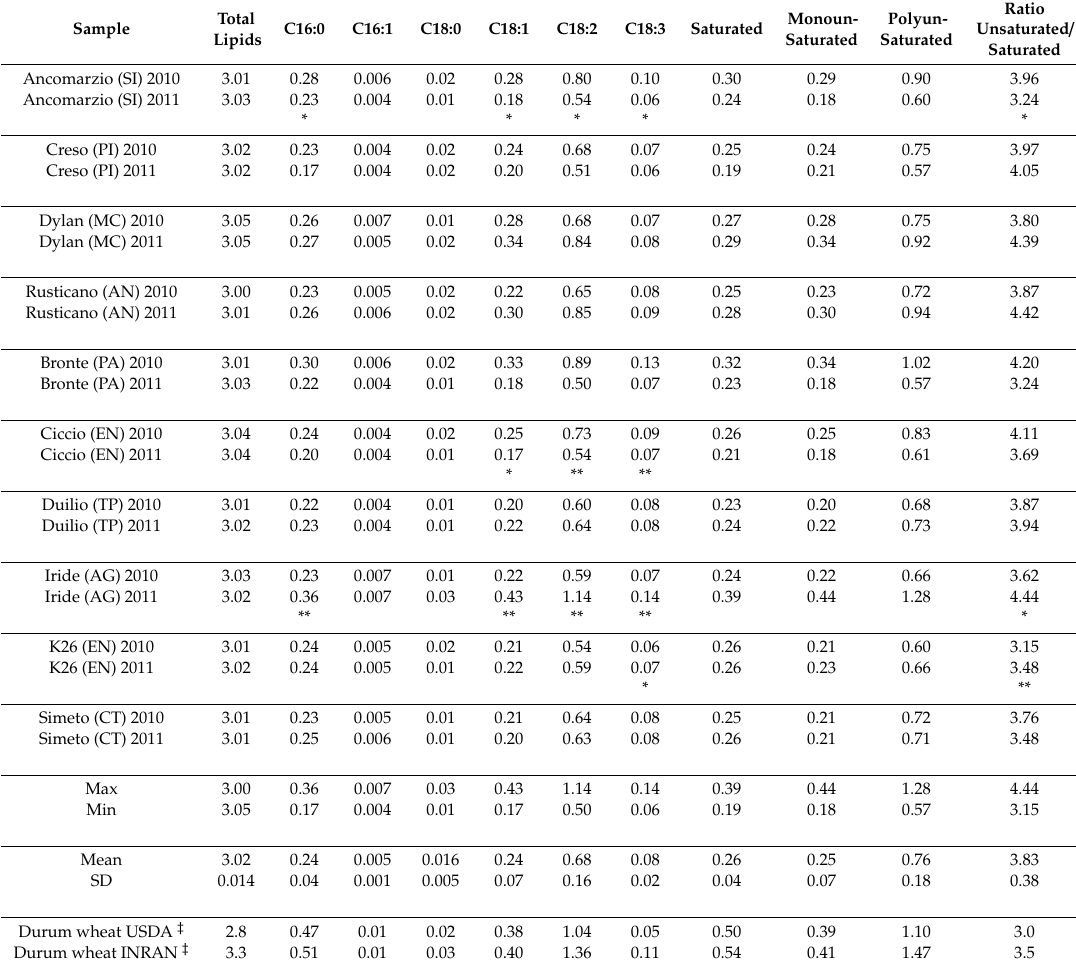
Table 3. Fatty acids in 10 Italian durum wheat cultivars, grown in di ff erent locations for two consecutive years (g / 100 g sample,